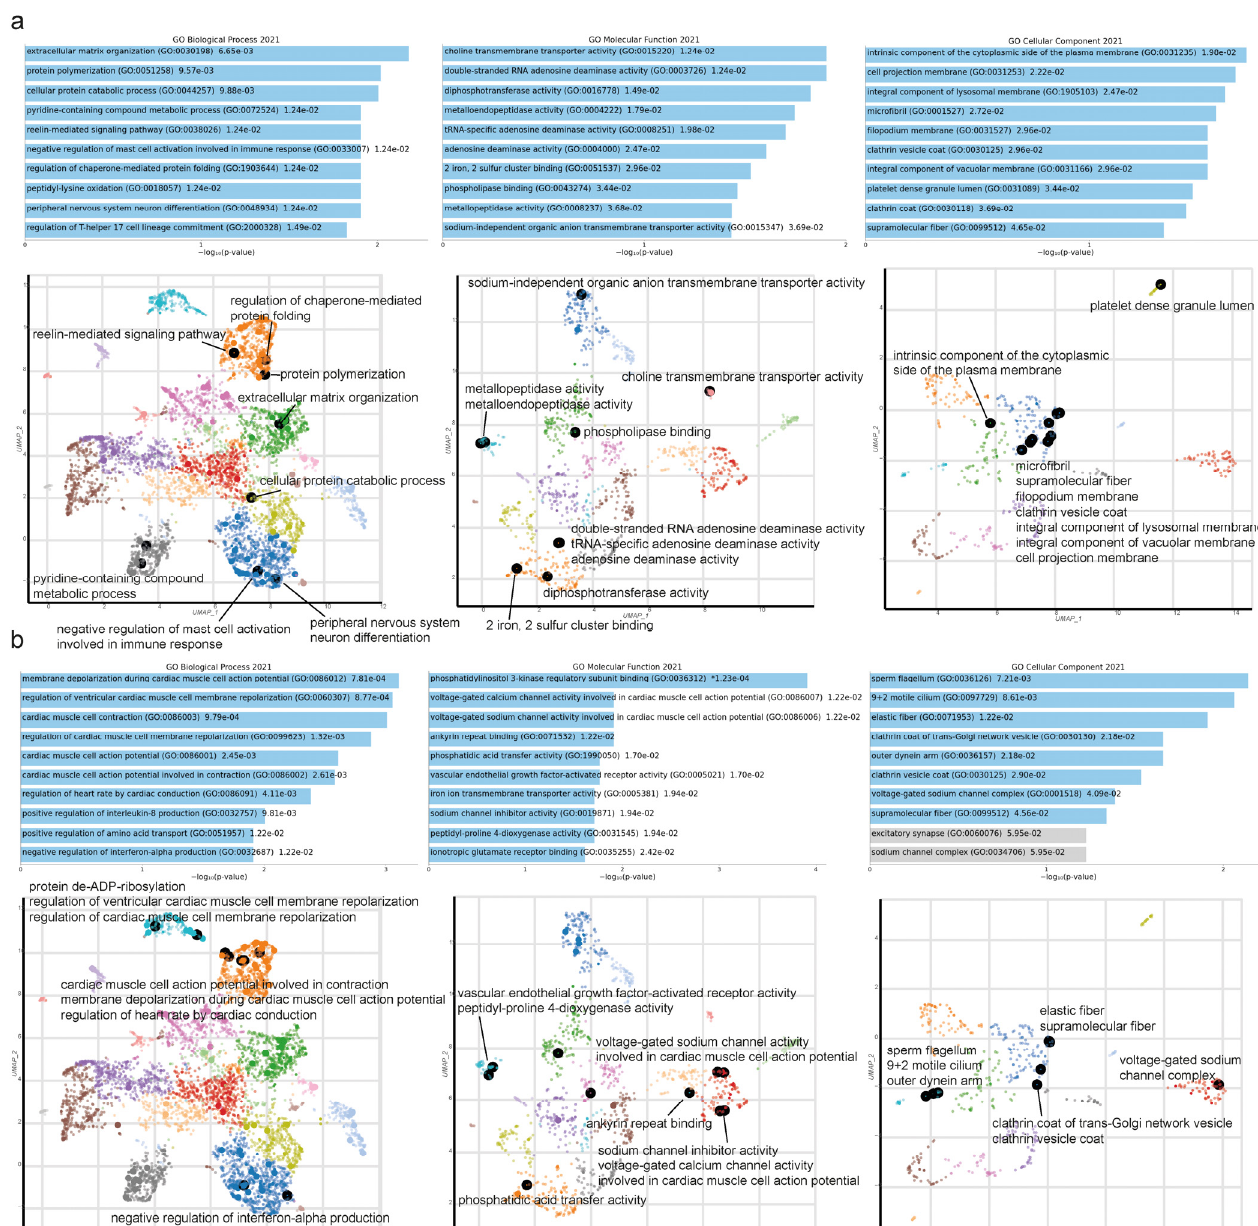
Figure 3. Bar charts (upper panel) show the GO terms being significantly enriched in the upper ( a ) and lower ( b ) 50 deregulated genes in pediatric RUNX1/RUNX1T1 AML patients (GSE75461 dataset), along with their corresponding p -values. Statistically significant GO terms (adj. p < 0.05) are depicted with an asterisk (*). Scatterplots below show clusters of similar gene sets, the significantly enriched terms of which are denoted.